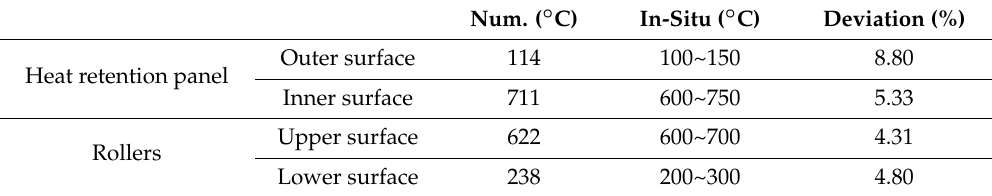
Table 3. Comparison of the numerical data and the in-situ data for different surfaces with the traditional passive heat retention panel.